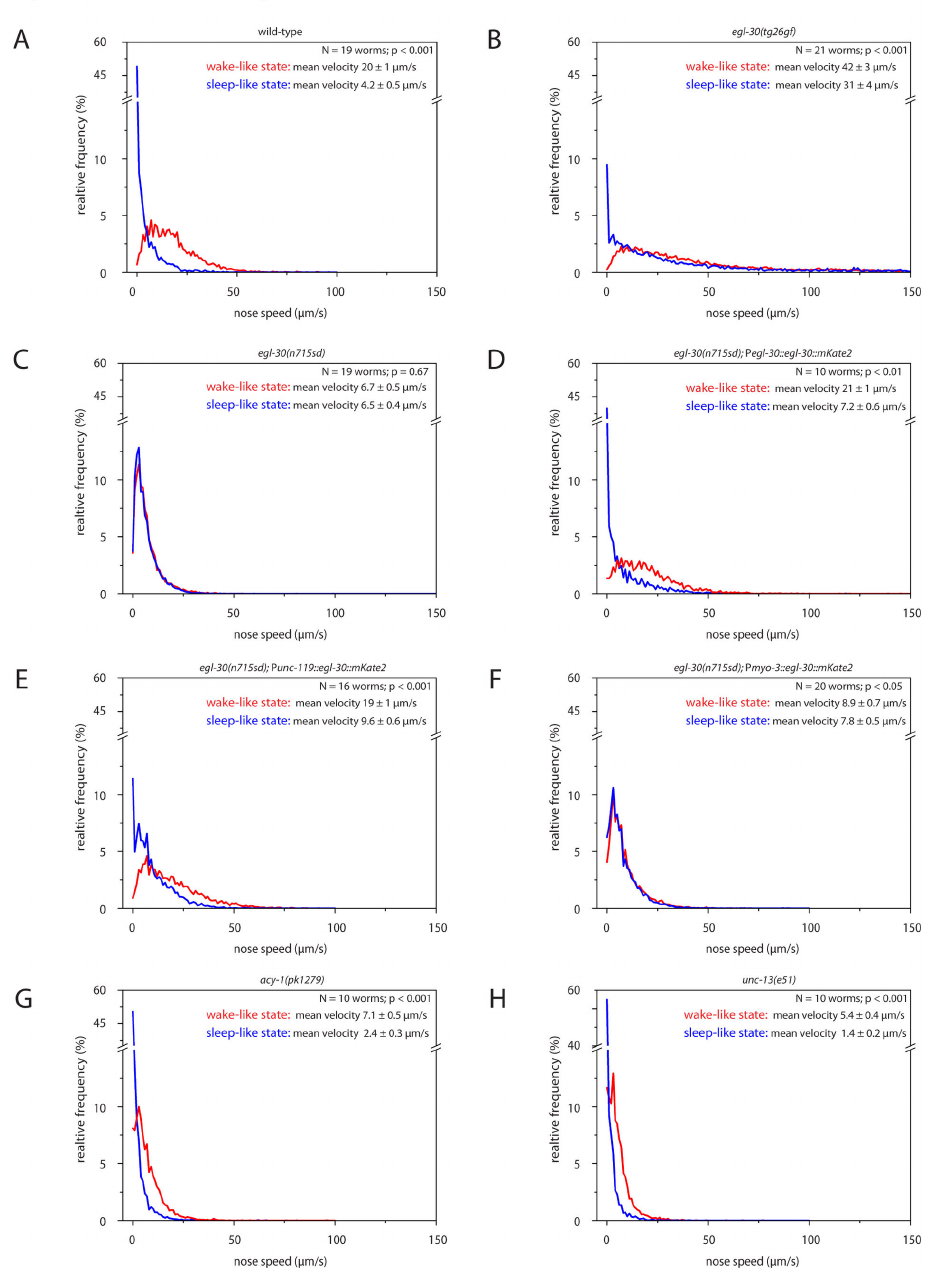
Figure 3. Probability distribution of nose speed in egl-30 mutants, egl-30 rescue mutants and hypoactive mutants during wake-like and sleep-like behavior. Probability distribution of nose speeds during wake-like and sleep-like state. A wild type, B egl-30 (tg26gf), C egl-30 (n715sd), D egl-30 (n715sd) transformed with a rescue construct expressed from its endogenous promoter, E egl-30 (n715sd) transformed with a pan-neural rescue construct, F egl-30 (n715sd) transformed with a muscle rescue construct, G acy-1 (pk1279lf) and H unc-13 (e51lf). We can exclude that the rescue of egl-30 (n715sd) was caused by the myo-3 or unc-119 promoter regions, because transgenic worms that contained these promoters without the egl-30 cDNA such as pmyo-3::gcamp (Figure 4) or punc-119::gcamp (Figure 5) did not show rescue (Figure 4, 5 and data not shown). Complete immobility of the nose was virtually absent in egl-30 mutants, rescued by the egl-30 transgene and partially rescued by the pan-neural rescue construct. Values displayed show mean nose speed ± SEM. A paired sample Wilcoxon test was used for statistical testing of wake-like versus sleep-like behavior. doi: 10.1371/journal.pone.0075853.g003 PLOS ONE |